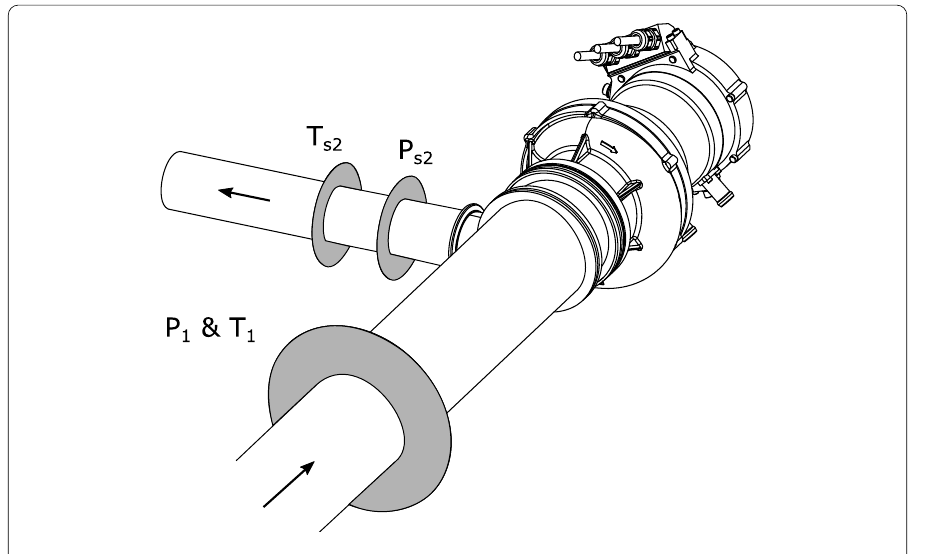
Figure 4 Compressor stage layout and measurements